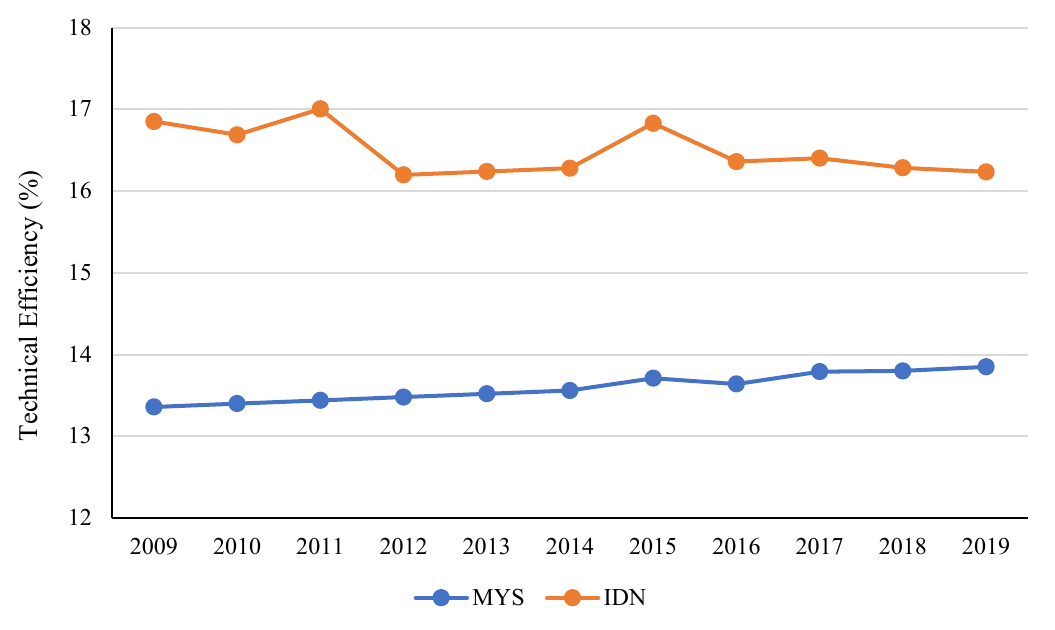
Figure 2. Average Technical Efficiency for Malaysia and Indonesia. Table 6. Malaysia Palm Oil Export Potential and Export Gap, average million USD